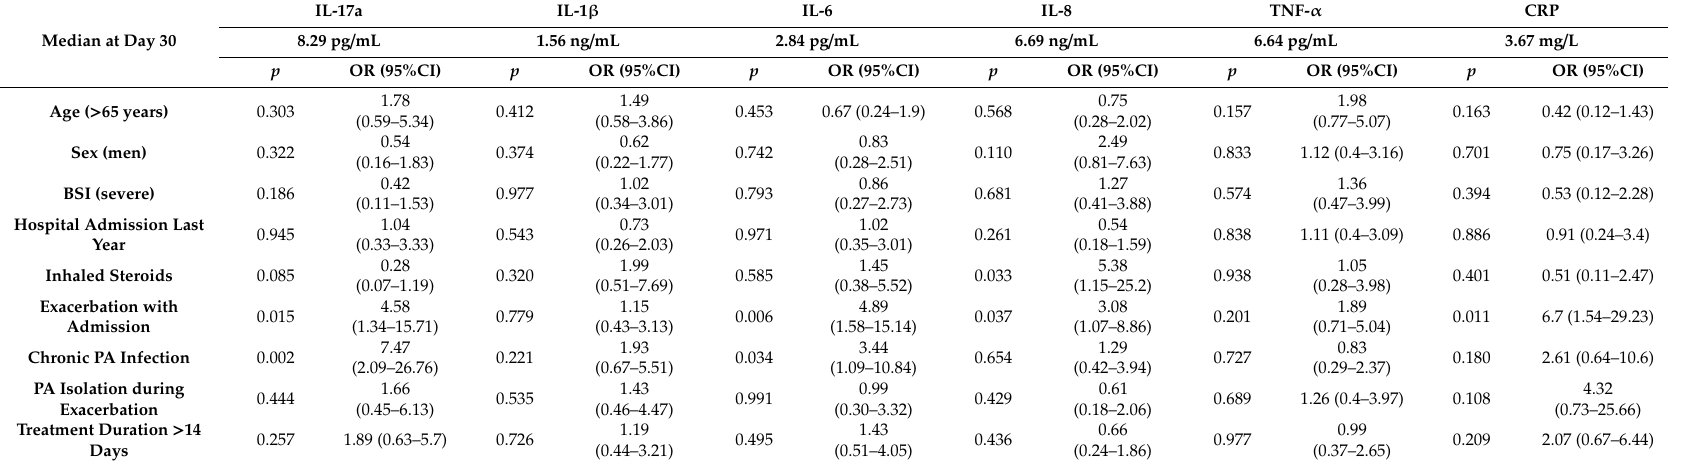
Table 3. Multivariable analyses for raised proinflammatory cytokines and hsCRP at day